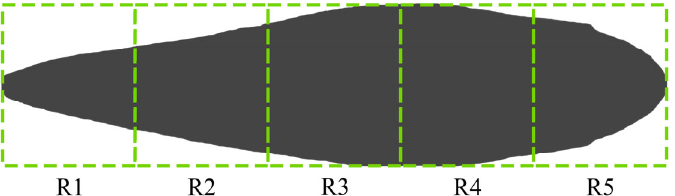
Figure 2. Body division with rectangles ( R 1...5 ). The five green rectangles represent the division of the kohaku body into five equal parts along the body length.